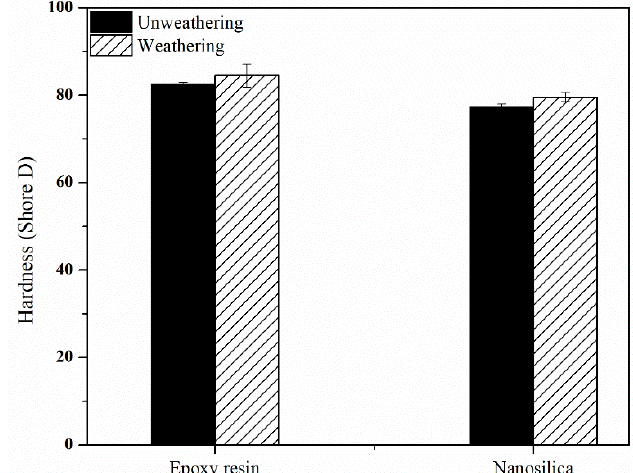
Figure 7. Hardness of nanocomposite-fiber samples after accelerated aging.